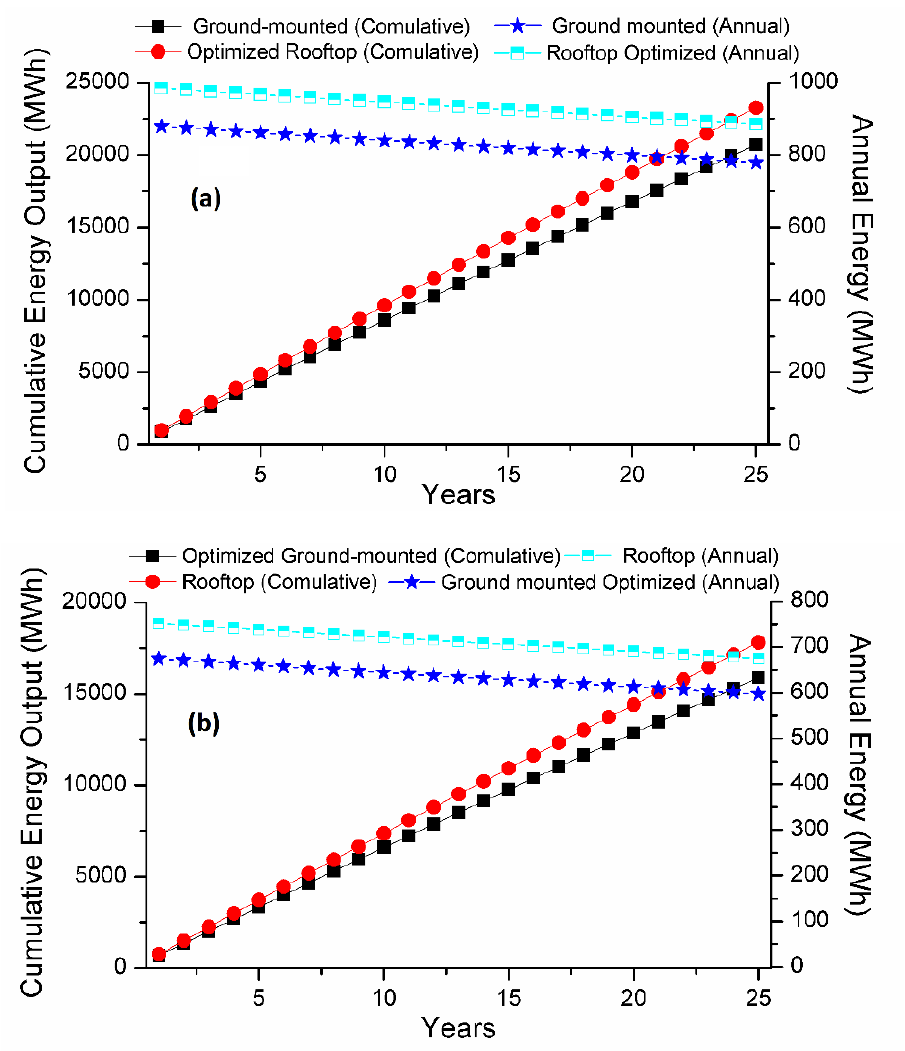
Figure 12. Annual and cumulative energy comparison. ( a ) Optimized rooftop vs. ground-mounted PV. ( b ) Optimized ground-mounted vs. rooftop PV.